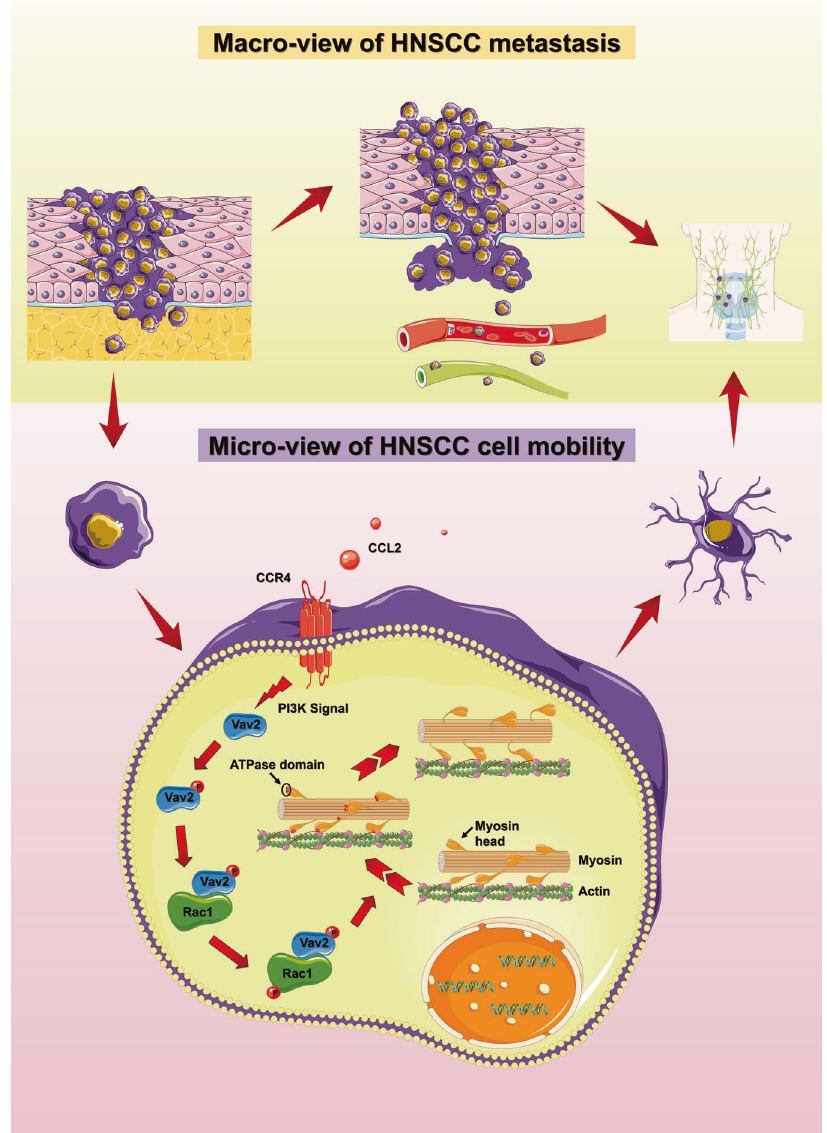
Fig. 6 The proposed mechanism of how CCL2 enhances cell motility of HNSCC. The proposed models described the effect of CCL2 on cell migration and tumor metastasis in HNSCC. From a macroscopic perspective, HNSCC can metastasize to distant sites through lymphatics and blood vessels, among which cervical lymph node metastasis was most frequent. From a microscopic perspective, HNSCC cells can secrete CCL2 which could bind to the membrane receptor CCR4 by autocrine or paracrine function. Then, the PI3K pathway transduces extracellular signals into the cell and activates the Vav2-Rac1-MLC signal axis. Finally, CCL2 promotes HNSCC cytoskeletal remodeling and pseudopodia formation, enhances the mobility of HNSCC cells, and promotes the metastasis of